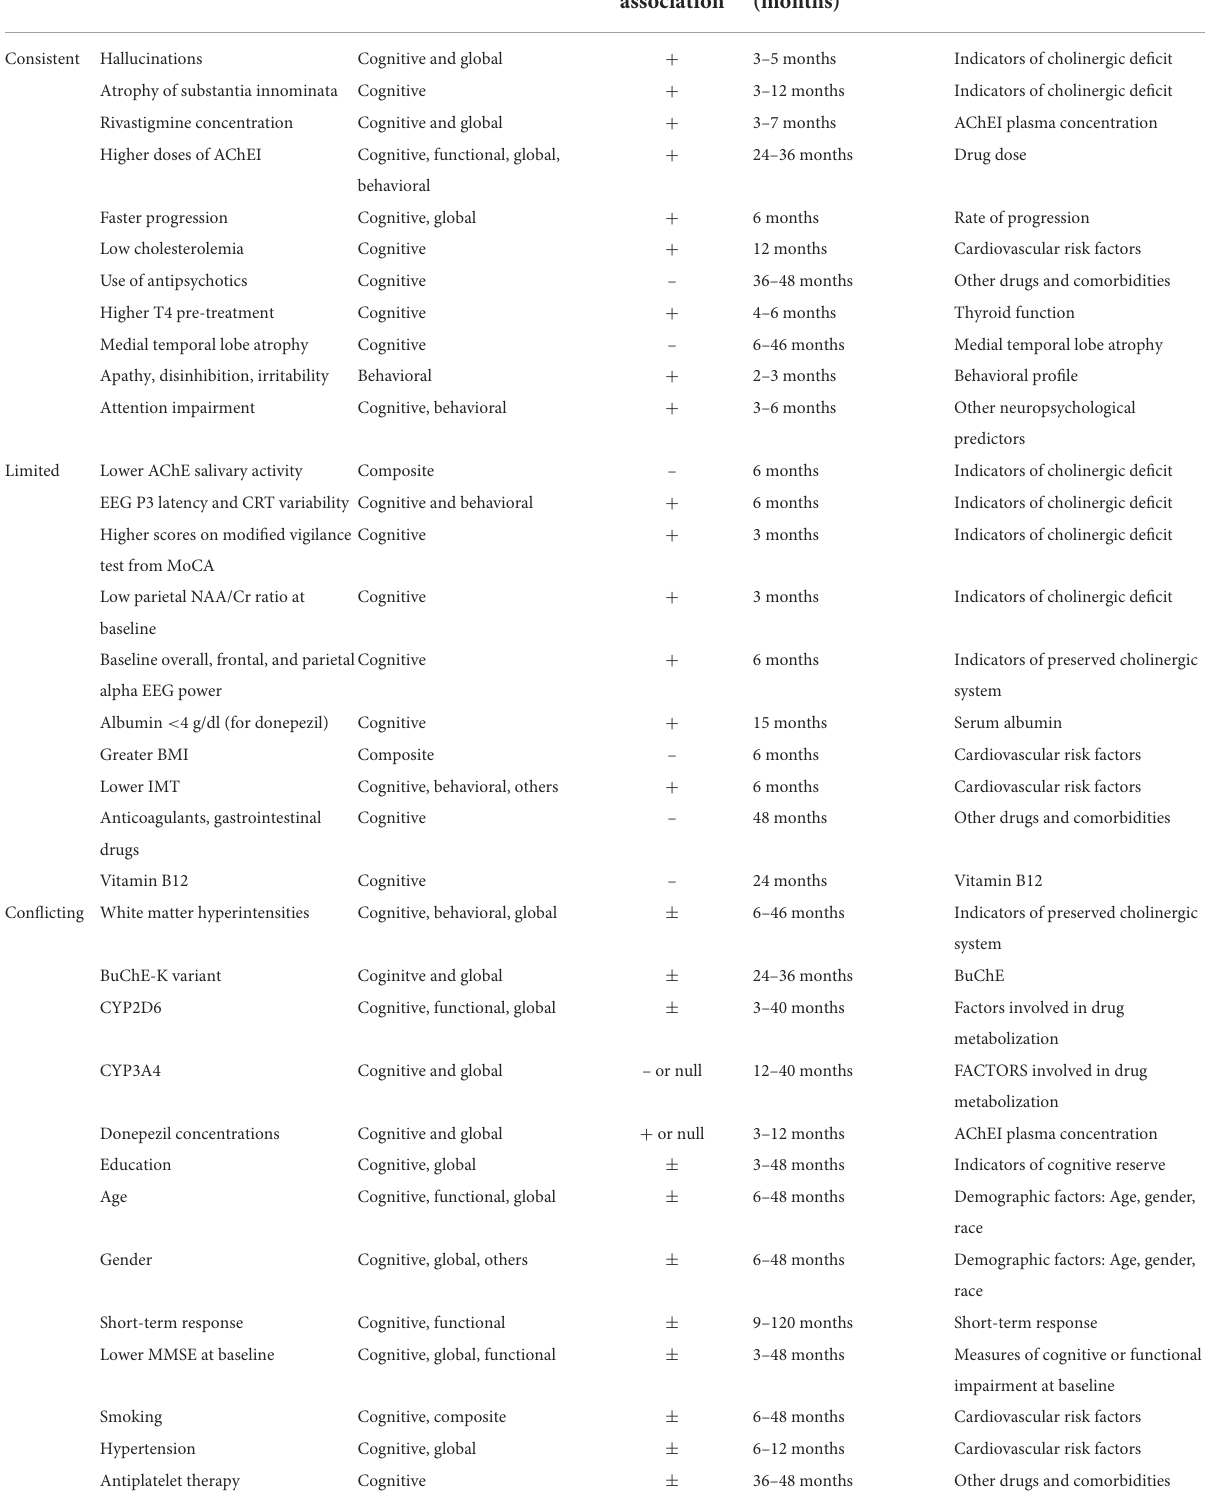
TABLE 11 Summary of the most relevant predictors based on their